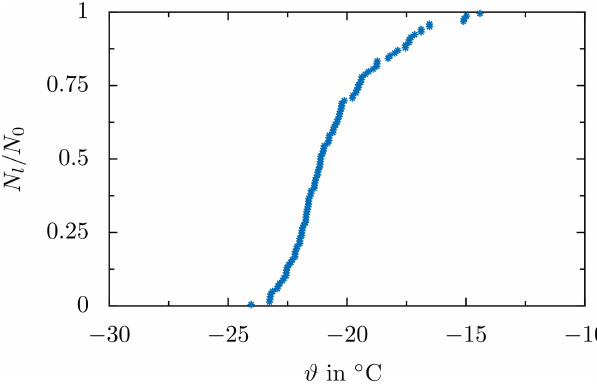
Figure 13. Droplet survival curve for a constant cooling rate of ˙ T = 5Kmin − 1 and without electric field strength, derived through merging the survival curves obtained from several test runs at the respective field strength, resulting in a minimum of 83 droplets per shown survival curve. Data were taken from Löwe et al.